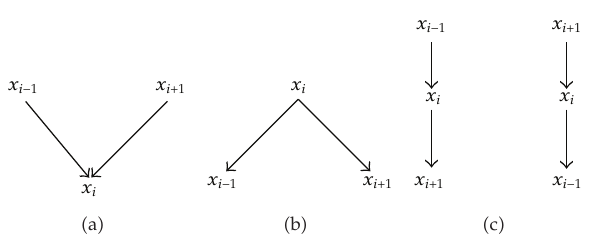
Figure 4: (cid:5) a (cid:6) A converging connexion. (cid:5) b (cid:6) A diverging connexion. (cid:5) c (cid:6) A serial